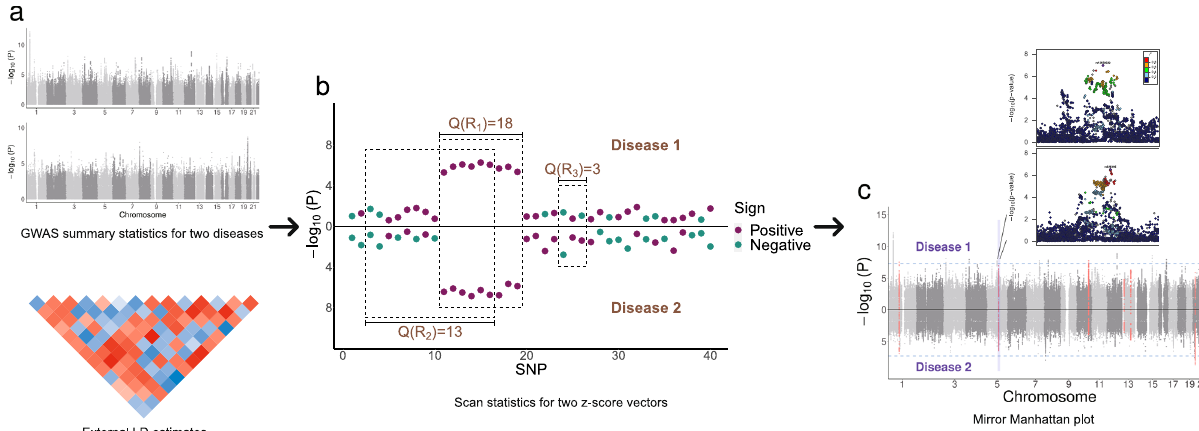
Fig. 1 LOGODetect work fl ow. a The inputs of LOGODetect include GWAS summary statistics for two traits and a reference panel for LD estimation. b Scan statistic is de fi ned over a region, as the LD-weighted inner product of two z -score vectors in this region. A large absolute value of the scan statistic would hint at local genetic correlation. c LOGODetect identi fi es genome segments showing consistent associations with two